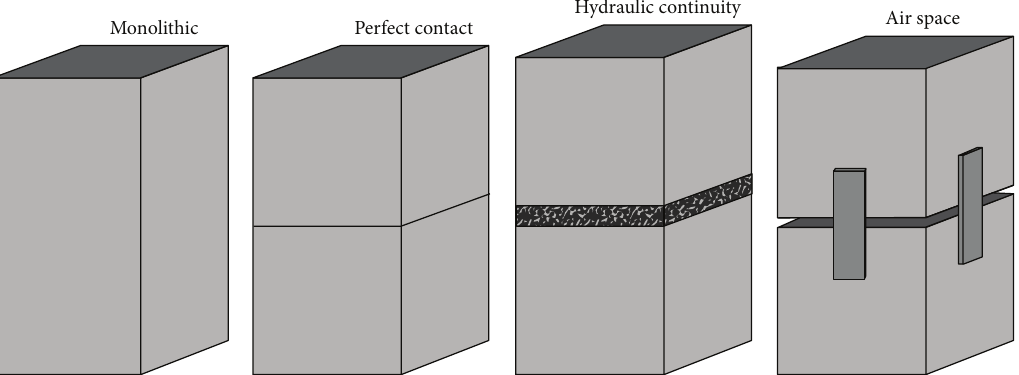
Figure 1: Virtual representation of the different types of specimen tested.